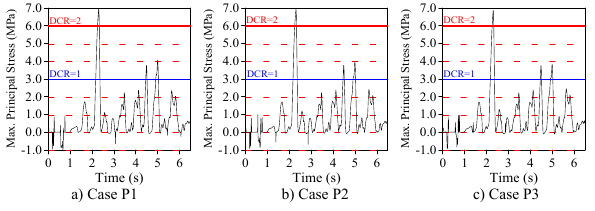
Fig. 14. The time histories of maximum stresses at nodal point 48 of the arch dam for Case P. Fig. 16. The variation of maximum displacements on II-II section of the arch dam for Case W The time histories of horizontal displacements in upstream-downstream direction at the nodal point 48 (Fig.4) of the arch dam are plotted in Fig. 17 (a-c) for each case. The time histories of displacements for each case are similar to each other. This shows that different mass densities do not change the results affluently. Fig. 15. Performance curves at nodal point 48 of the arch dam for Case P1, P2, and P3.